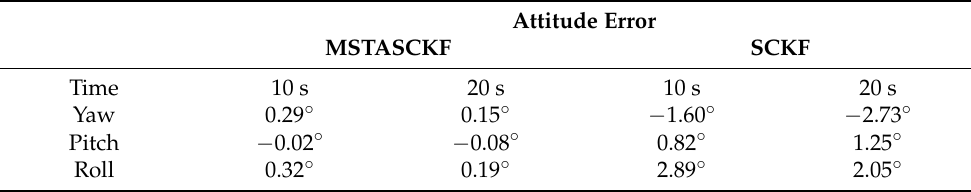
Table 4. Thea attitude error comparison between MSTASCKF and SCKF when the alignment time was 10 s and 20